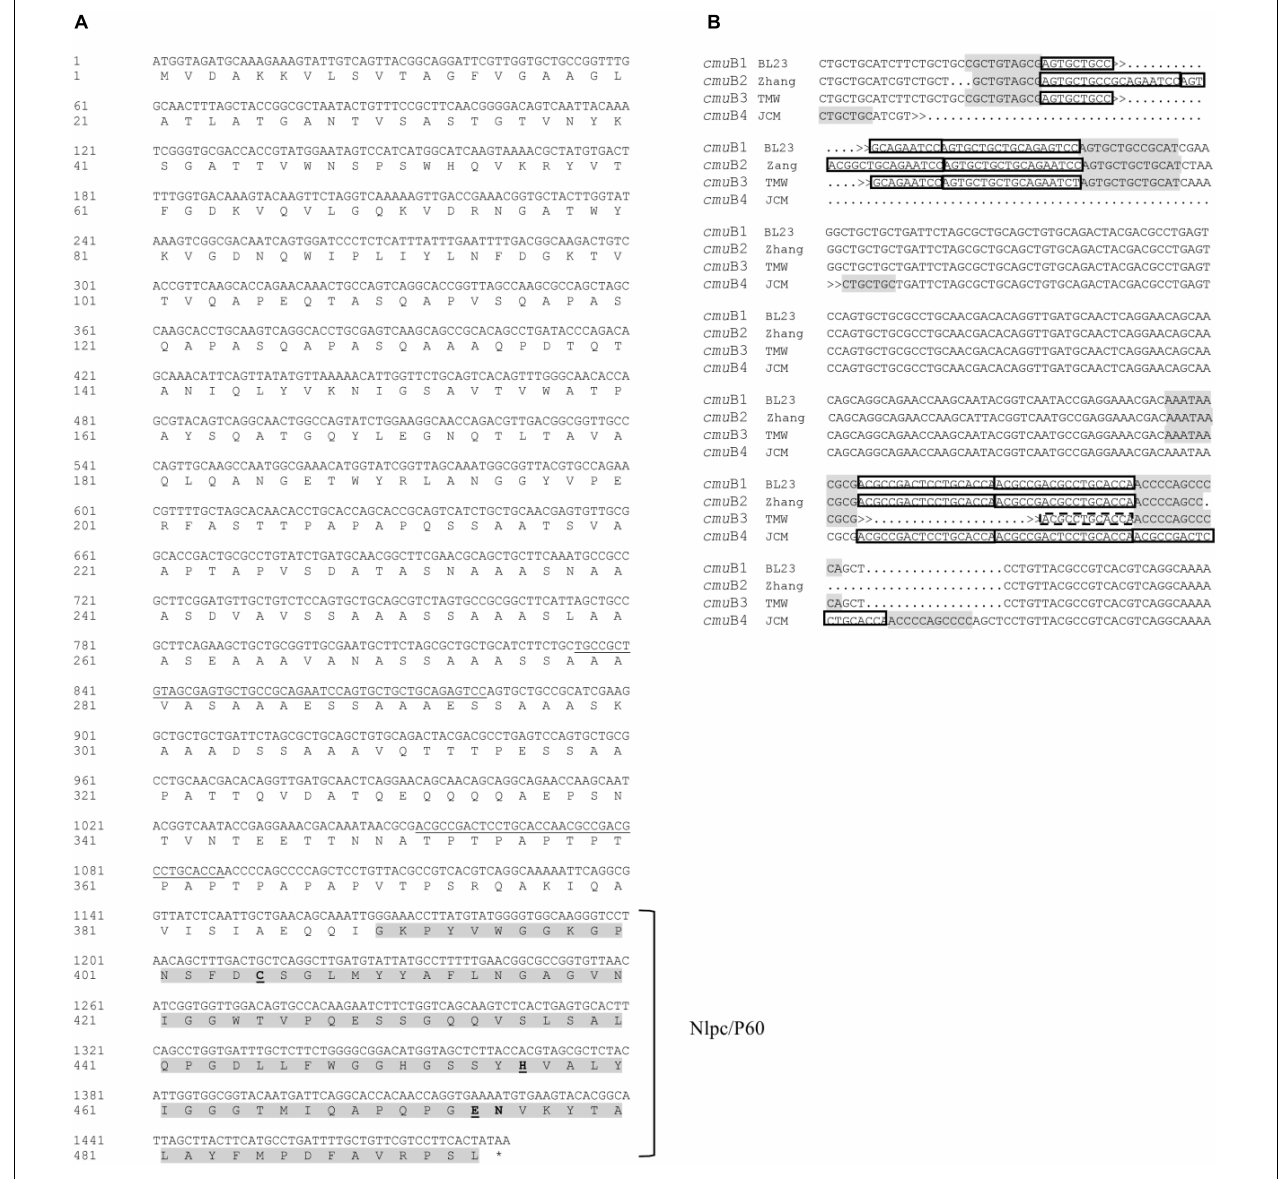
FIGURE 1 | Features of L. casei BL23 cmu B, P75 encoding sequence. (A) The translated sequence where the NlpC/P60 domain peptide sequence is enhanced and Tandem Repeat (TR) DNA (minisatellite) are underlined in the nucleotide strand. Putative active triad amino acid residues C-H-E tentatively deduced from proposed consensus are marked in bold and underlined (Aramini et al., 2008; Sanz-Gaitero et al., 2014). (B) The TR sequences found in homologous genes from L. casei BL23 and L. paracasei strains that constitute four alleles. TR is framed in boxes and conserved flanking regions are shadowed in gray. Names of the alleles and representative strains are: cmu B1 BL23 ( L. casei BL23) , cmu B2 Zhang ( L. paracasei Zhang and identical sequences from L. casei LOCK919, L. paracasei ZFM54 and L. paracasei NRRL B), cmu B3 TMW ( L. paracasei TMW 1.1434) and cmu B4 JCM ( L. paracasei JCM 8130). GenBank references and nucleotide sequences in FASTA format can be found in Supplementary Table S2